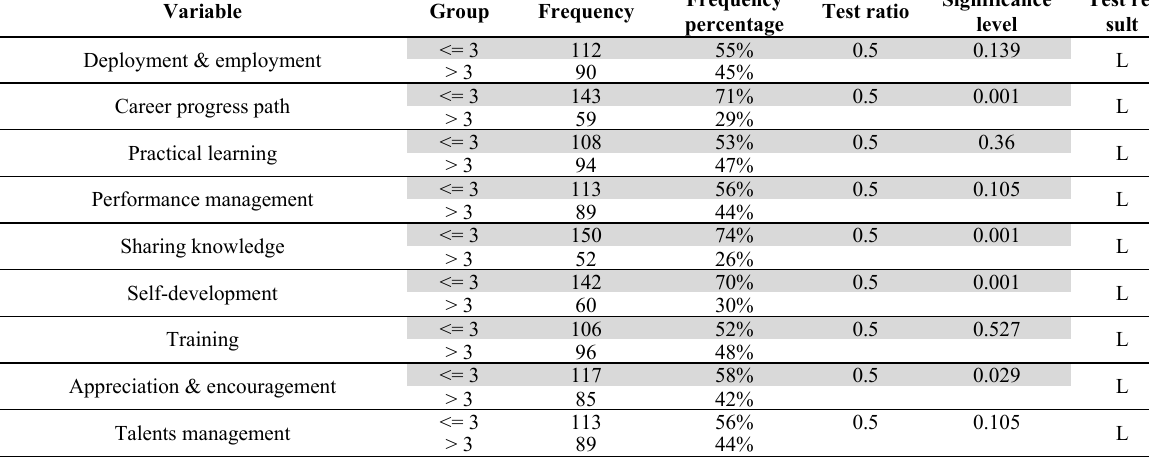
Binomial test results to examine the status of talent management components